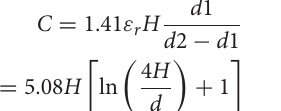
, F + N takes the place 1 1